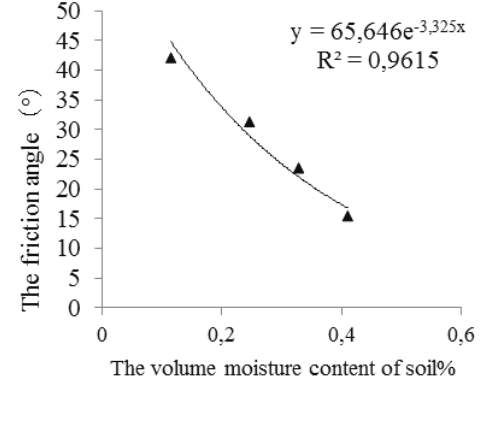
Figure 5: Relationship between cohesive force and moisture content of dry red soil.